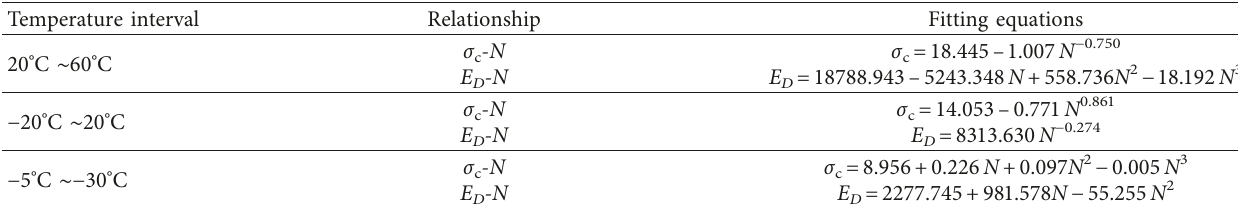
Table 9: Fitting equations for semirigid base material under different temperature intervals. Temperature interval Relationship Fitting